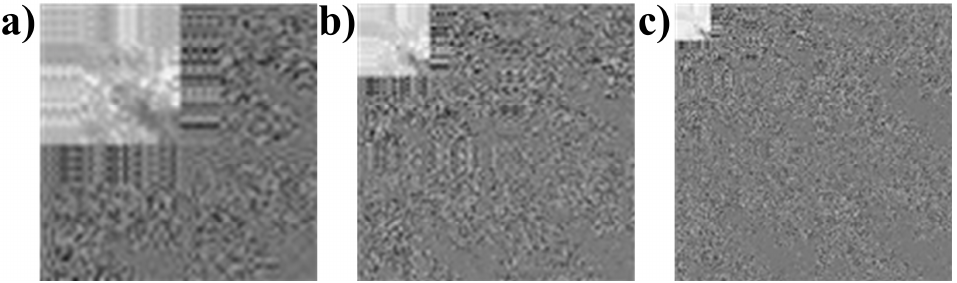
Figure 3. Wavelet decomposition of the MODIS image from 1 January 2014: ( a ) one-scale wavelet decomposition, ( b ) two-scale wavelet decomposition, and ( c ) three-scale wavelet decomposition.